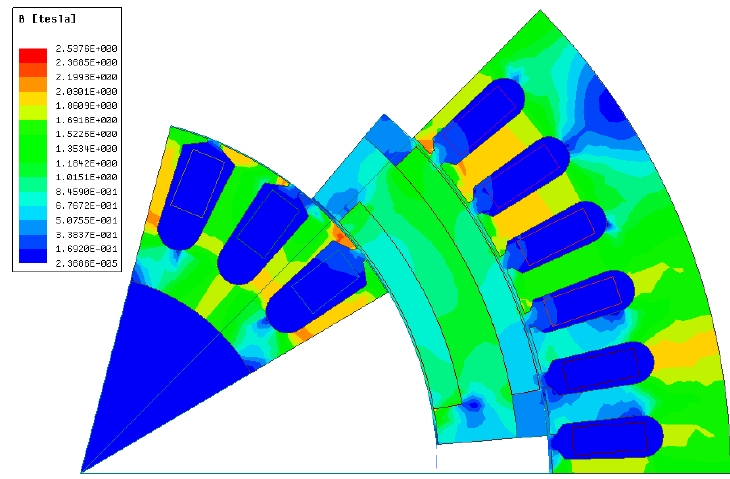
Figure 14. Magnetic density distribution of CSPM motor at rated load.